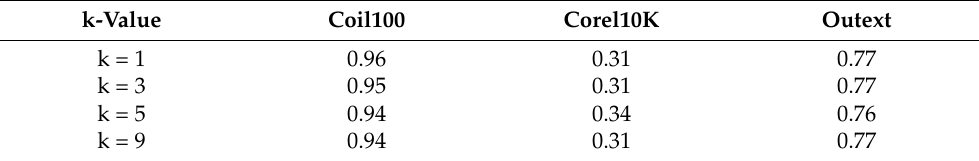
Table 6. Mean accuracy for KNN classifier with different values of k on three datasets.